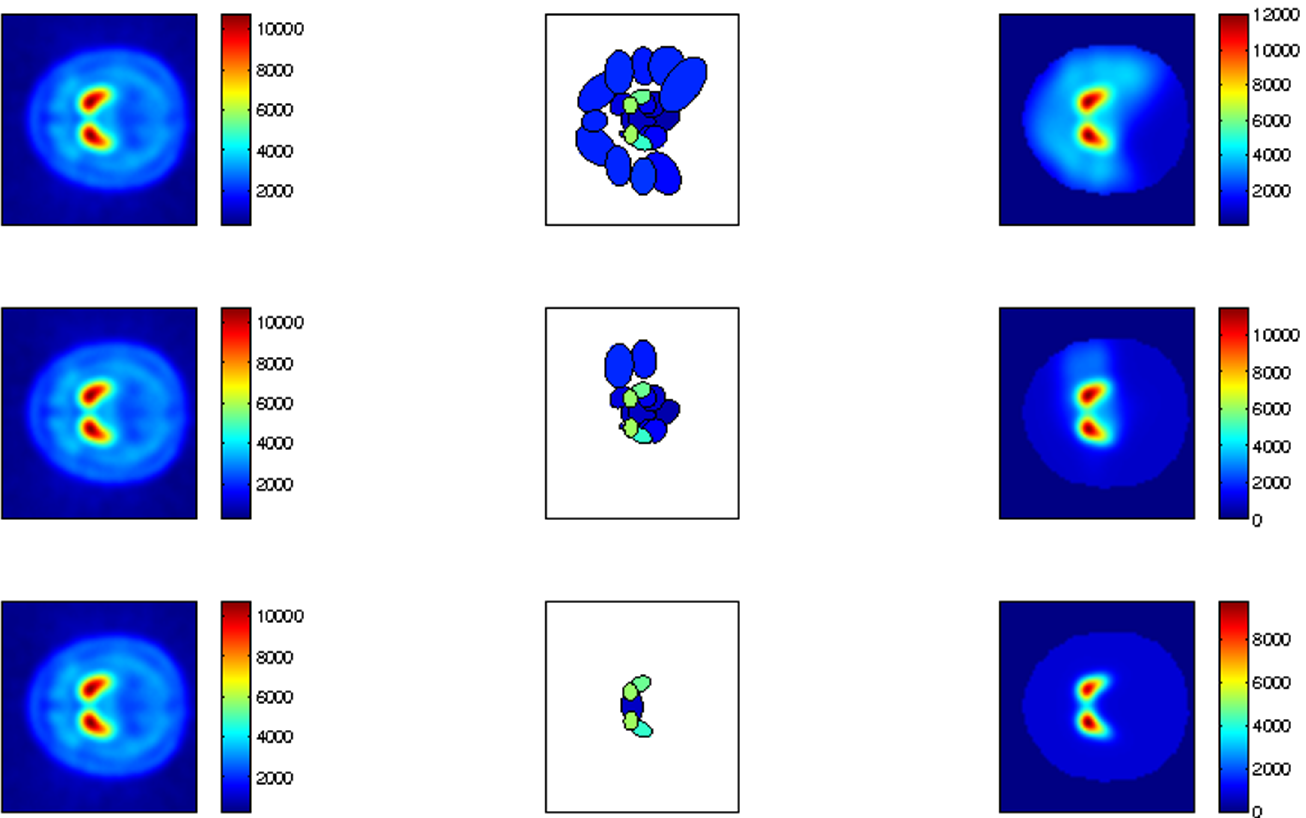
Fig 2. Filtered GMM average image according to different probability thresholds. Left column: DaTSCAN image of average normal subjects. Central column: different location and intensity of relevant clusters for different values of threshold η = 4 (cid:3) 10 − 6 , 4 (cid:3) 10 − 5 and 4 (cid:3) 10 − 4 . Right column: filtered GMM image reconstruction according to Eq